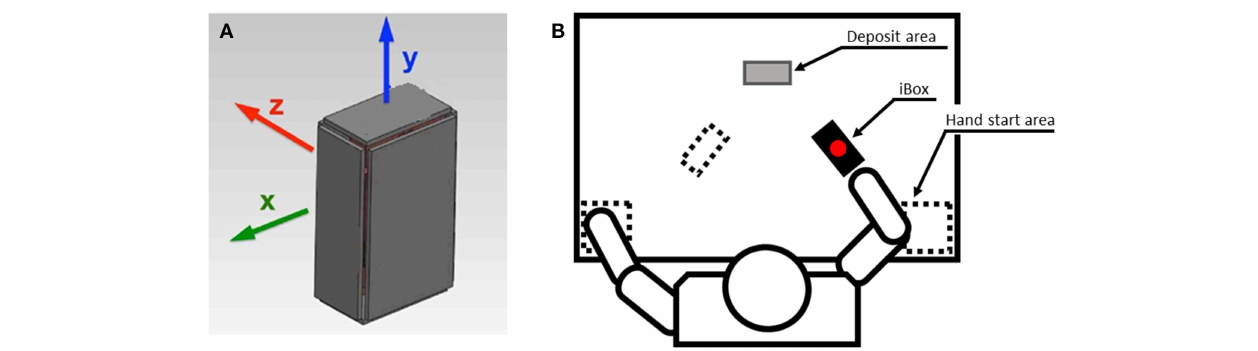
Jebsen Taylor hand function test (reference from less-affected side)